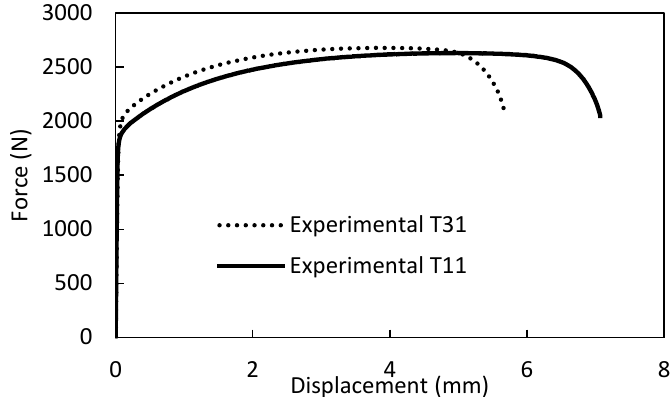
Figure 3. Comparison of force displacement for 𝑇 11 , 𝑇 31 .